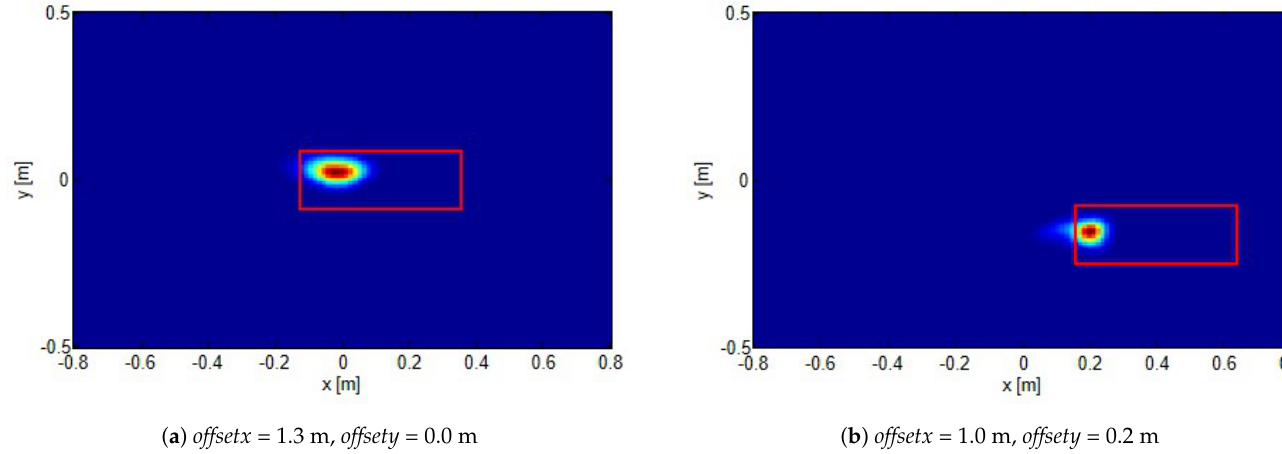
Figure 5. Normalized reconstructions for target located at position 2 shown in Figure 3b for different investigation domain offsets (reported in the figures). The red rectangles show the actual target positions.